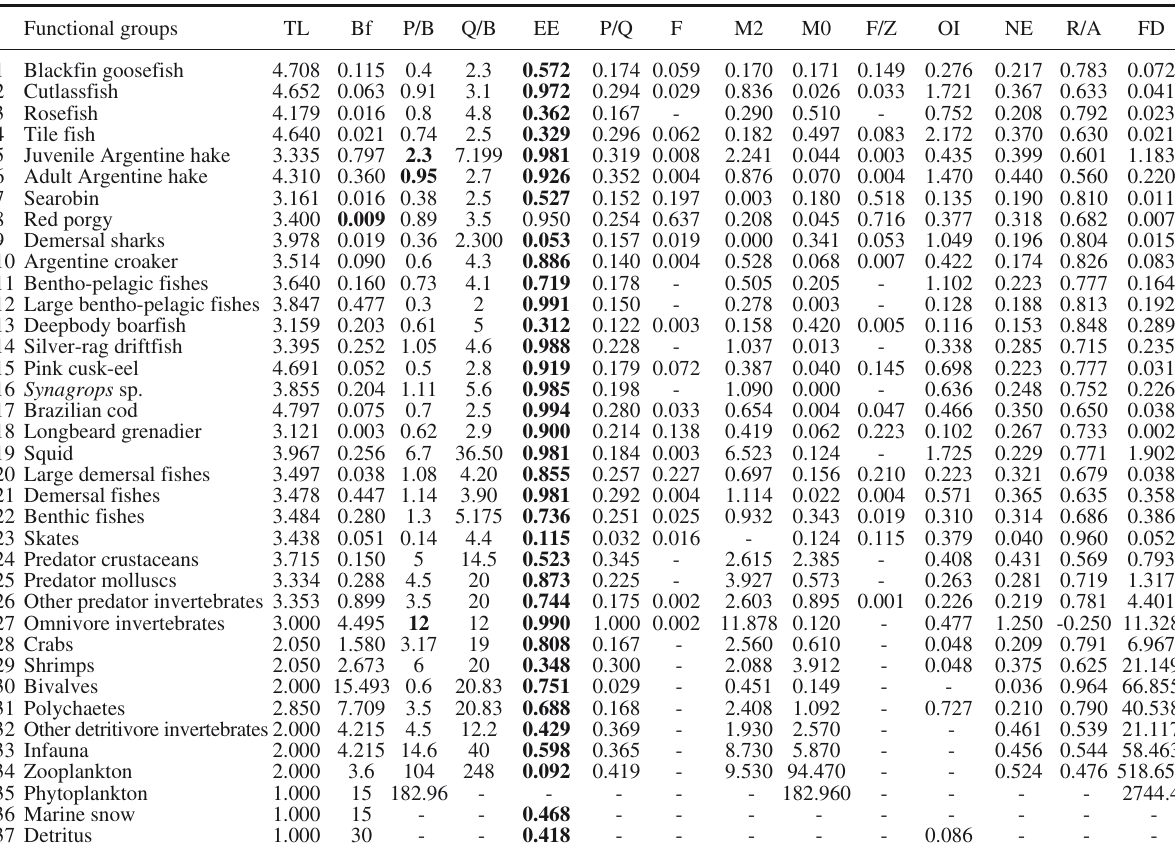
Table 4. – Input data modified to balance the model and the main output data. TL, Trophic level; Bf, final biomass (t km –2 ); P/B, production/ biomass ratio (yr –1 ); Q/B, consumption/biomass ratio (yr –1 ); EE, ecotrophic efficiency; P/Q, production/consumption ratio or gross efficiency; F, fishing mortality (yr –1 ); M2, predation mortality (yr –1 ); Mo, other natural mortality (yr –1 ); F/Z, exploitation rate; OI, omnivory index; NE, net efficiency; R/A, respiration/assimilation ratio; FD, flow to detritus (t km –2 yr –1 ). The “input” EwE estimated parameters are in bold. Functional